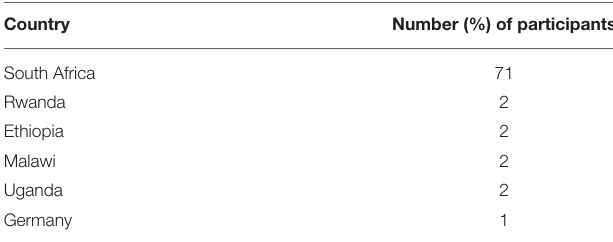
TABLE 2 | Distribution of participants by